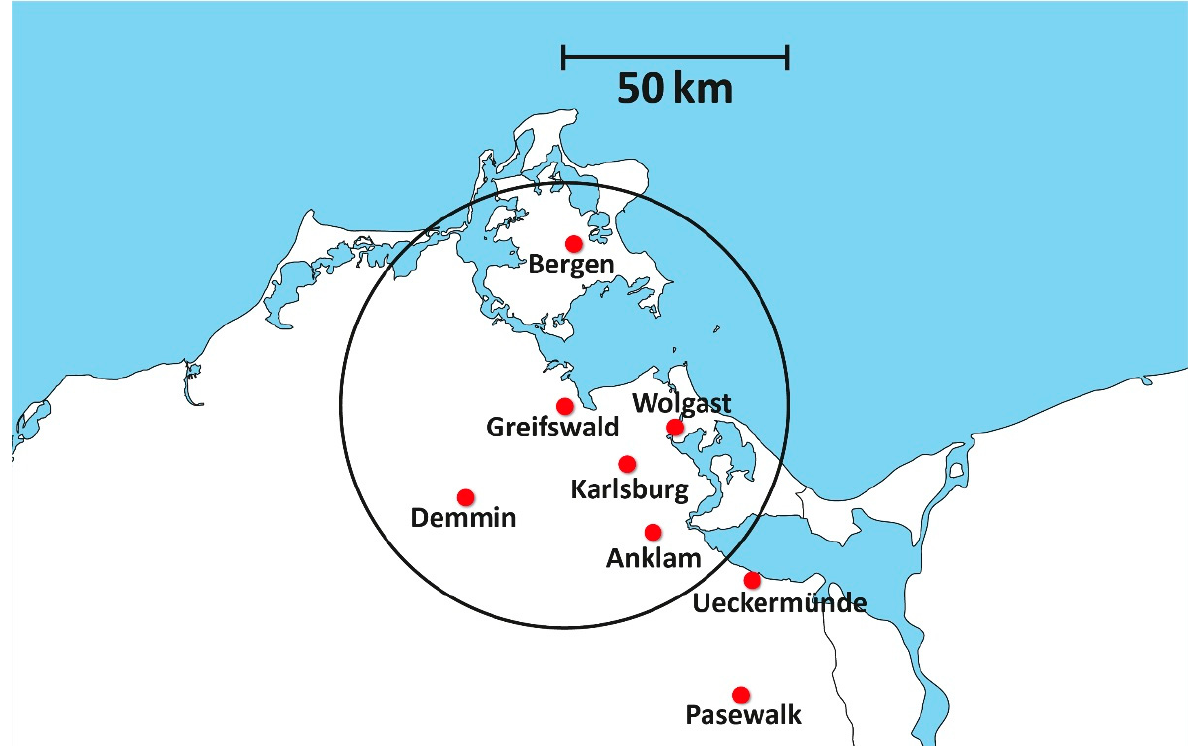
Figure 7. Geographical distribution of the German teleradiology network. The network has been running for more than 15 years. In Greifswald, there is a 24/7 radiological service in the university hospital. The surrounding city names represent the locations of connected houses that are also supplied in the network. According to German law, the backup method for downtime in teleradiology is a radiologist going to the relevant hospital and performing the examination there. Due to this restriction in German law, teleradiology was limited to hospitals that could be reached within an hour (Demmin and Karlsburg were not financed by the project). Conclusion: The loss of catchment areas of the hospitals due to a new territorial delimitation can be increased by the telemedical expansion of catchment areas. Telemedicine thus leads to better access to doctors in territorial states and to the better utilisation of medical services in the same regions (black circle, unbroken: catchment area of Greifswald University Hospital’s pathology department with telepathology. Red arrows: pathology connections.).